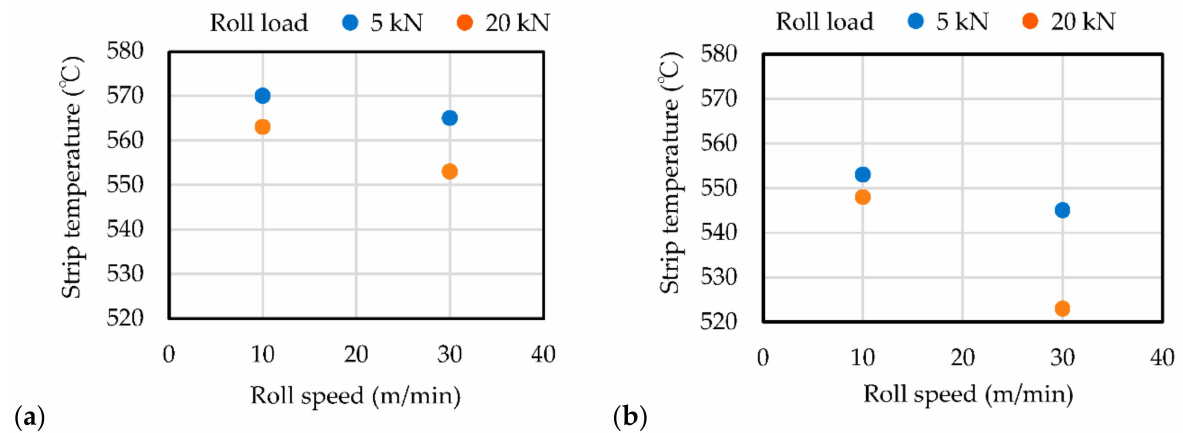
Figure 9. Effects of roll materials on strip temperature after exiting roll bite. The rolling speed was 10 or 30 m/min, and the roll load was 5 or 20 kN. ( a ) Mild steel roll and ( b ) copper